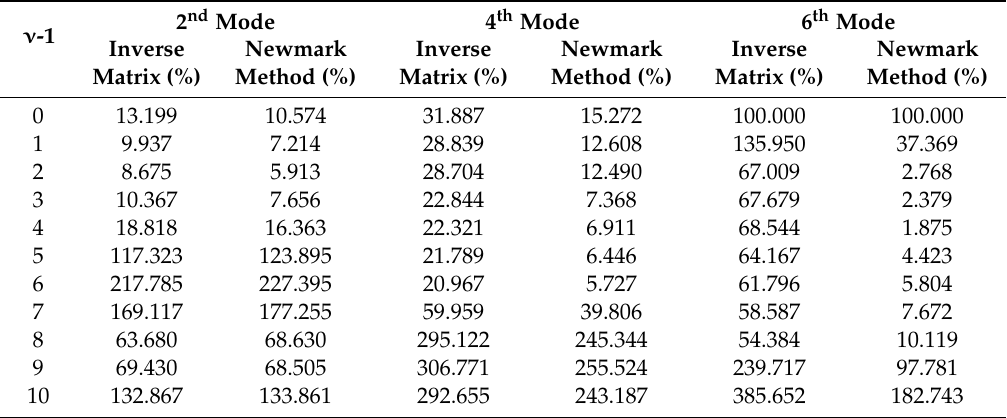
Table 2. List of the errors of the estimated (cid:101) R compared to the obtained R